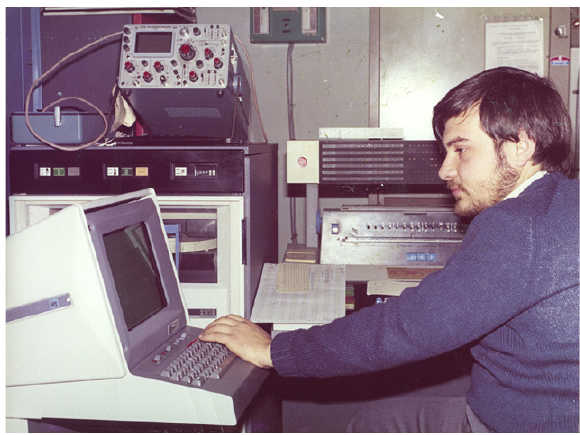
Fig. 1. – Jordi Salat working with the IBM 1130 computing system in the early 1970s. Source: Emilio Garcia